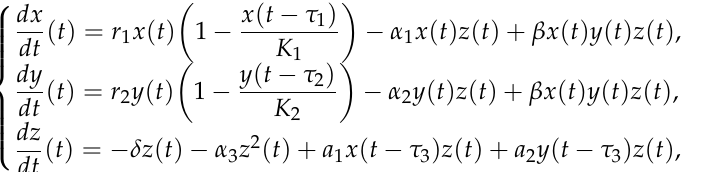
Table 1. The description of the parameters for model (1). Parameters Description r 1 The intrinsic growth rate for prey x r 2 The intrinsic growth rate for prey y K 1 The carrying capacity for x K 2 The carrying capacity for y α 1 The predation rate of prey x α 2 The predation rate of prey y β The rate of cooperation of preys x and y against predator z δ The predator death rate α 3 The rate of intra-species competition within the predators a 1 The transformation rate of predator to preys x a 2 The transformation rate of predator to preys